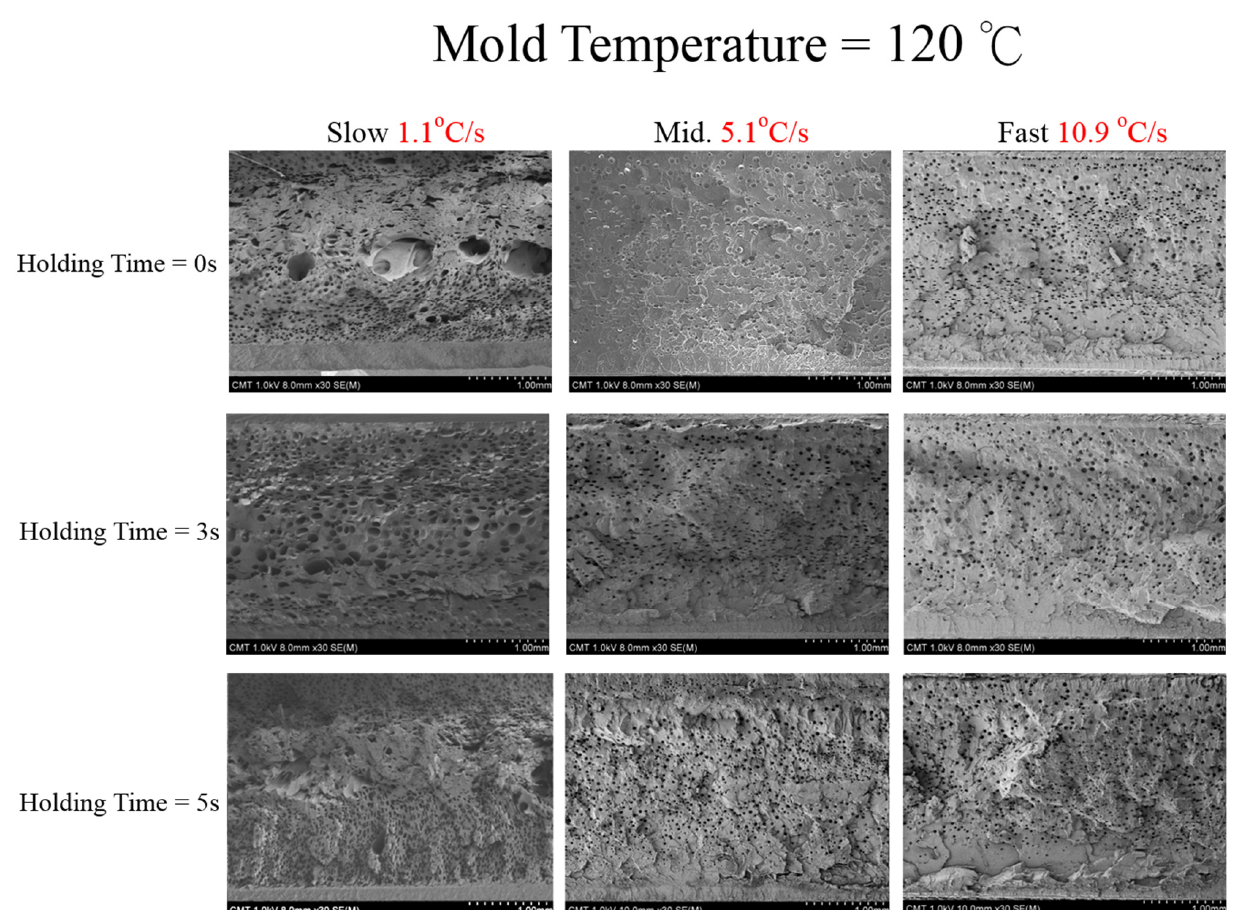
Figure 9. Effect of GCP holding time on foaming morphology under different cooling speeds at 120 °C mold temperature.